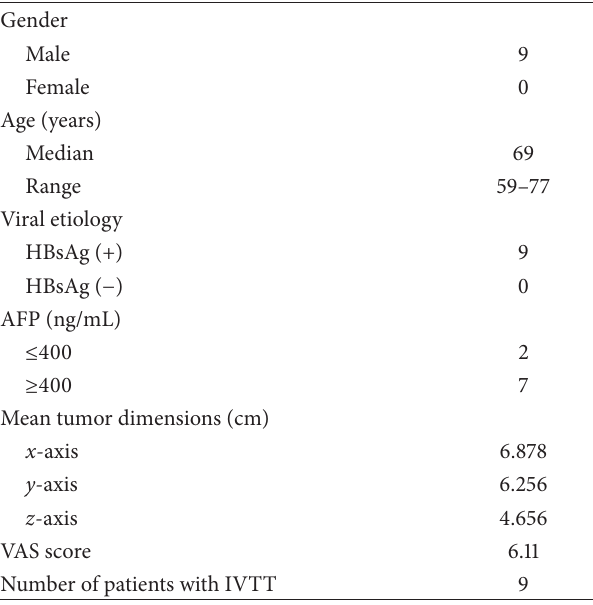
Table 1: Characteristic of patients, tumors, and